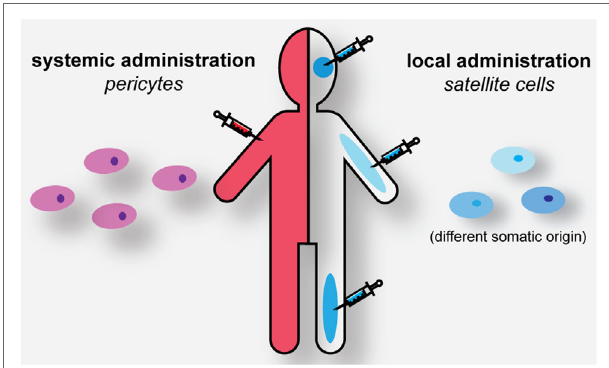
FiGURe 4 | Strategies for cell-based muscle therapy in myotonic dystrophy. Genome-edited autologous or HLA-matched pericytes (PCs) can be administered systemically for muscle healing. Genome-edited or HLA- matched satellite cells need to be engrafted locally in the corresponding muscles to have a regenerative